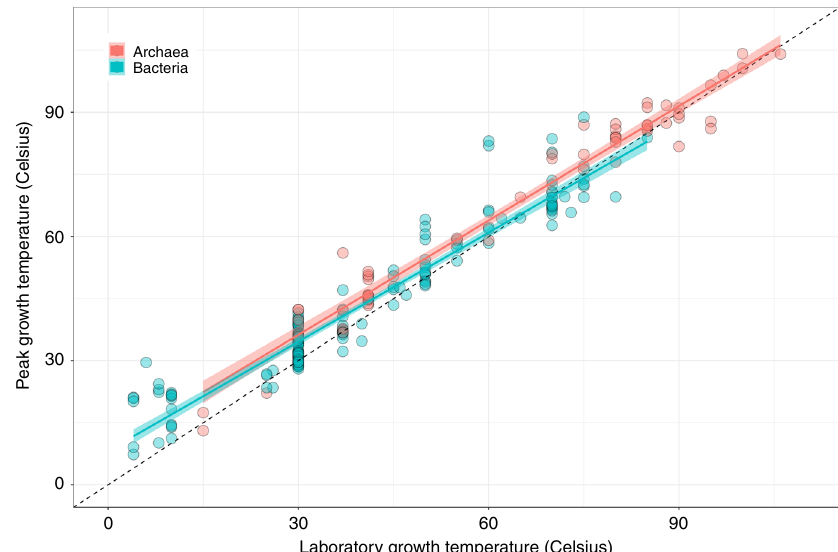
Fig. 2 Adaptation of prokaryotic strains to lab temperatures. Peak growth temperature ( T pk ) plotted against the laboratory growth temperature ( T lab ), with linear models fi t for bacteria (blue) and archaea (red) and a 1:1 line shown (black dashes). In general, there is a strong association of T pk with T lab (bacteria intercept = 8.20, slope = 0 : 88 with CI ± 0 : 04, R 2 = 0.92, p < 0 : 00001; archaea intercept = 8.59, slope = 0 : 92 with CI ± 0 : 05, R 2 = 0.96, p < 0 : 00001, linear regressions). The con fi dence intervals for the slopes do not include 1, however, indicating that prokaryotes tend to be unable to adapt to very high culturing temperatures. Source data are provided as a source data fi